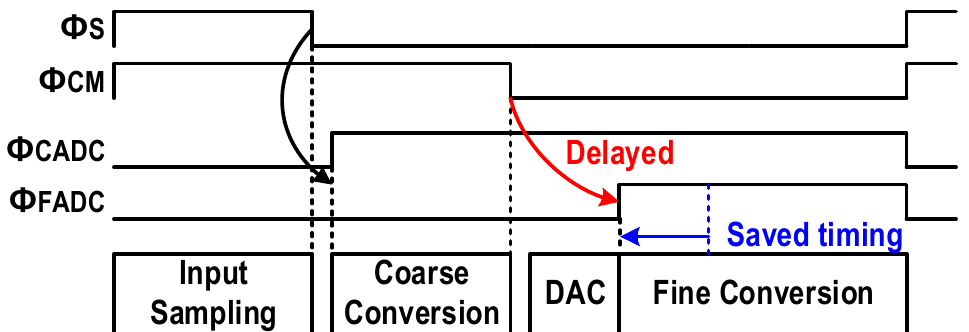
Figure 4. Timing diagram of the 6-bit 1.25 GS/s two-step flash ADC.